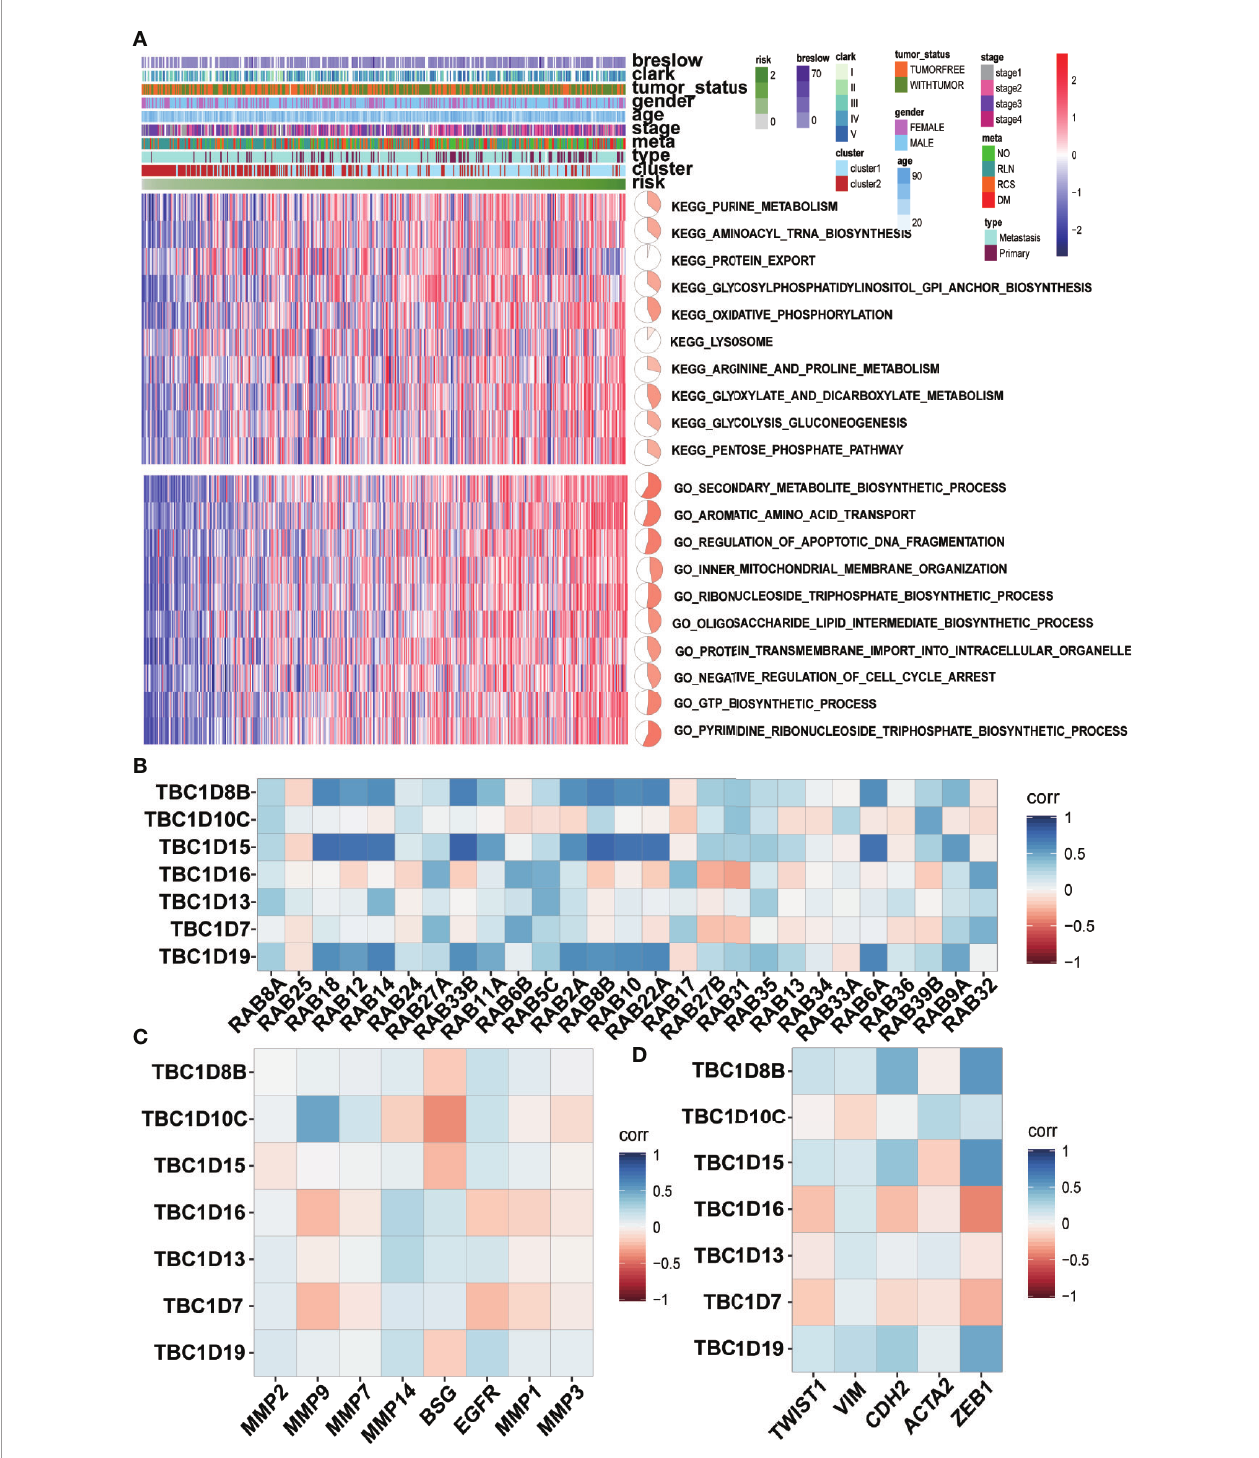
FIGURE 7 | GSVA analyses and correlation analysis. (A) GSVA analyses for the seven prognostic-associated TBCs. The distribution of risk scores, clinical characteristics and gene set enrichment of different pathways was displayed by heatmap. (B) Correlation analysis between the seven prognostic TBCs and several important RAB family (C) Correlation analysis between the seven prognostic TBCs and and invasion related genes (MMP2, MMP9, MMP7, MMP14, BSG, EGFR, MMP1, and MMP3). (D) Correlation analysis between the seven prognostic TBCs and EMT associated genes (TWIST1, VIM, CDH2, ACTA2, and